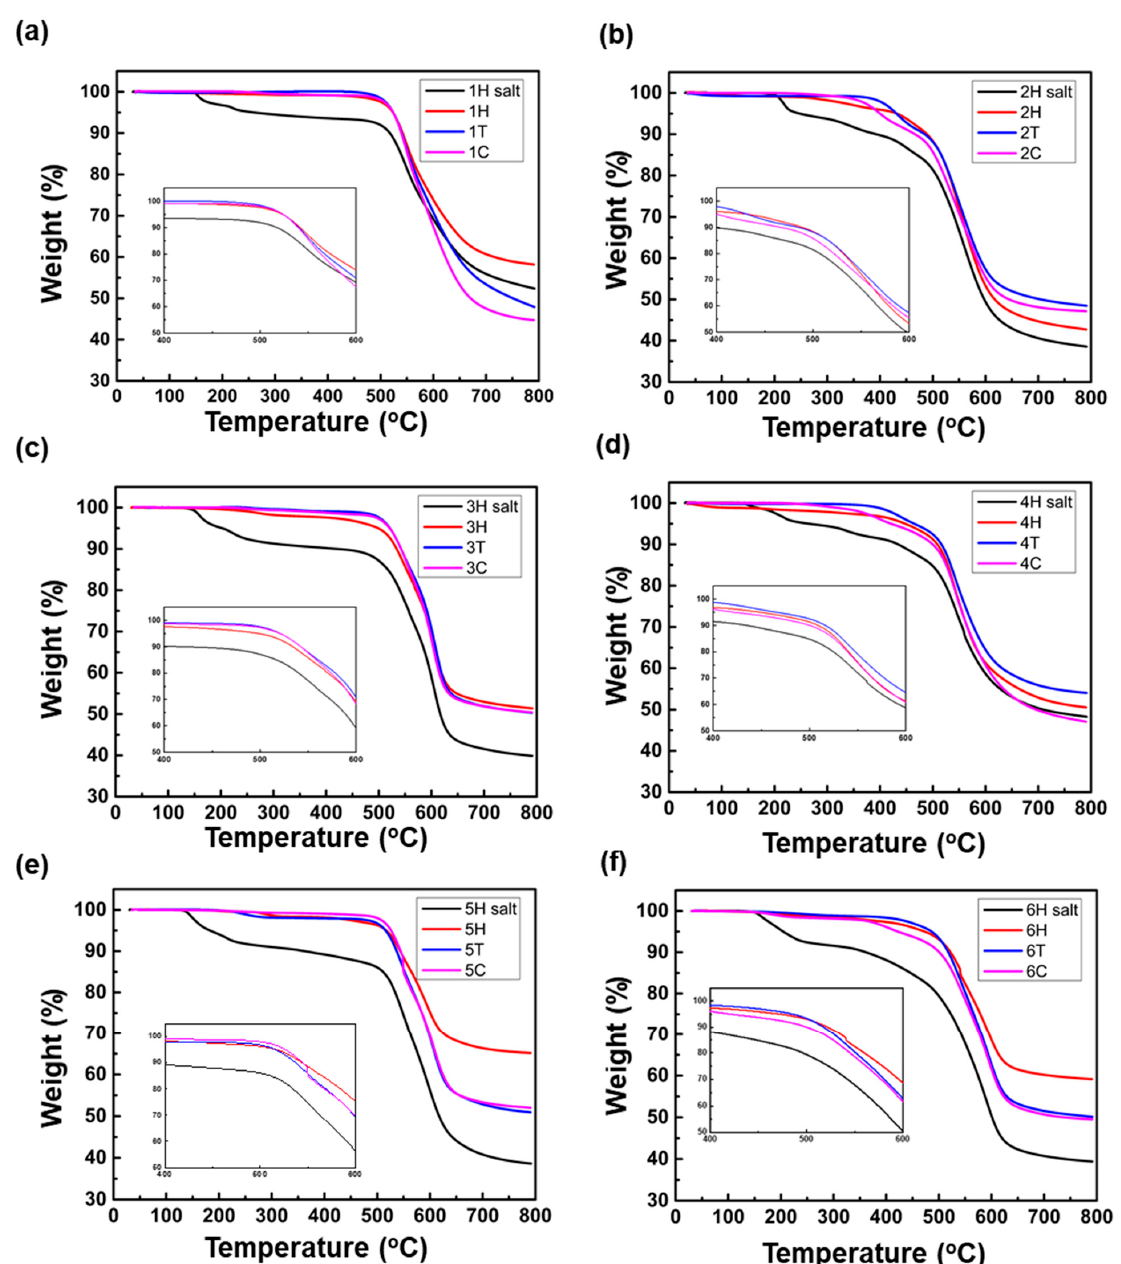
Figure 4. TGA analyses of monomer salts and polyimides synthesized with three different synthetic methods, ( a ) polyi- mide 1, ( b ) polyimide 2, ( c ) polyimide 3, ( d ) polyimide 4, ( e ) polyimide 5, ( f ) polyimide 6.